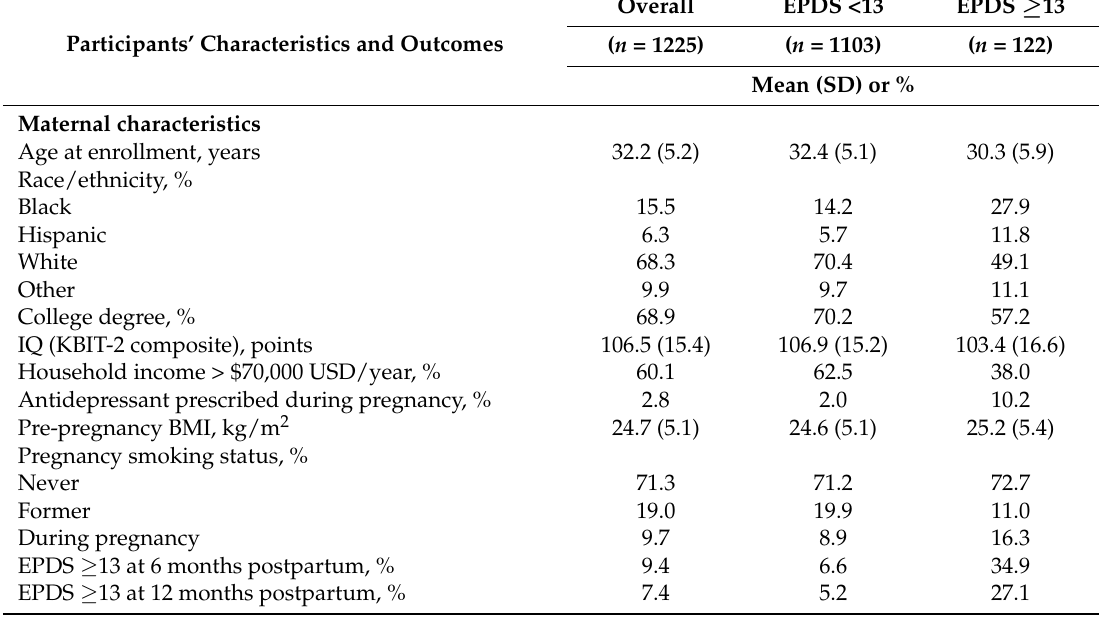
Table 1. Participants’ characteristics according to depressive symptoms at mid-pregnancy.